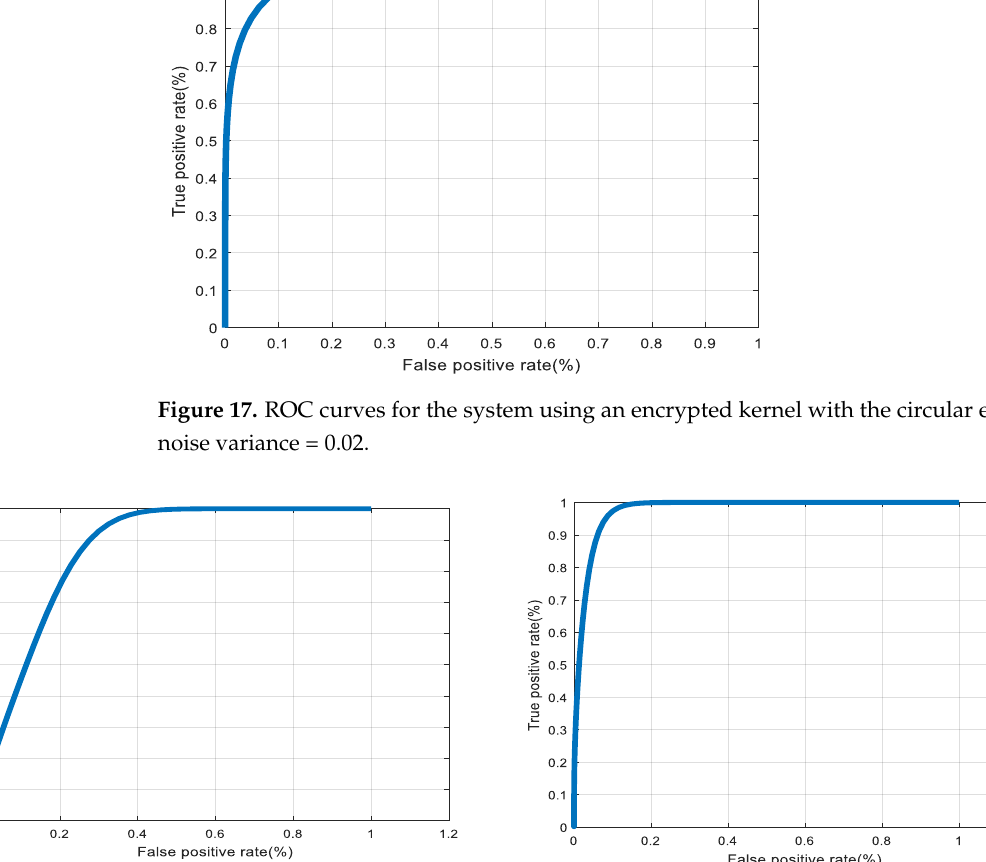
( b ) Figure 20. ROC curves for the system using an encrypted kernel in the DWT with similar keys of encryption with a noise variance of ( a ) 0.01, and ( b ) 0.02. ( a ) ( b ) Figure 21. ROC curves for the system using an encrypted kernel in the DWT with different keys of encryption with a noise variance of ( a ) = 0.01, and ( b ) = 0.02.